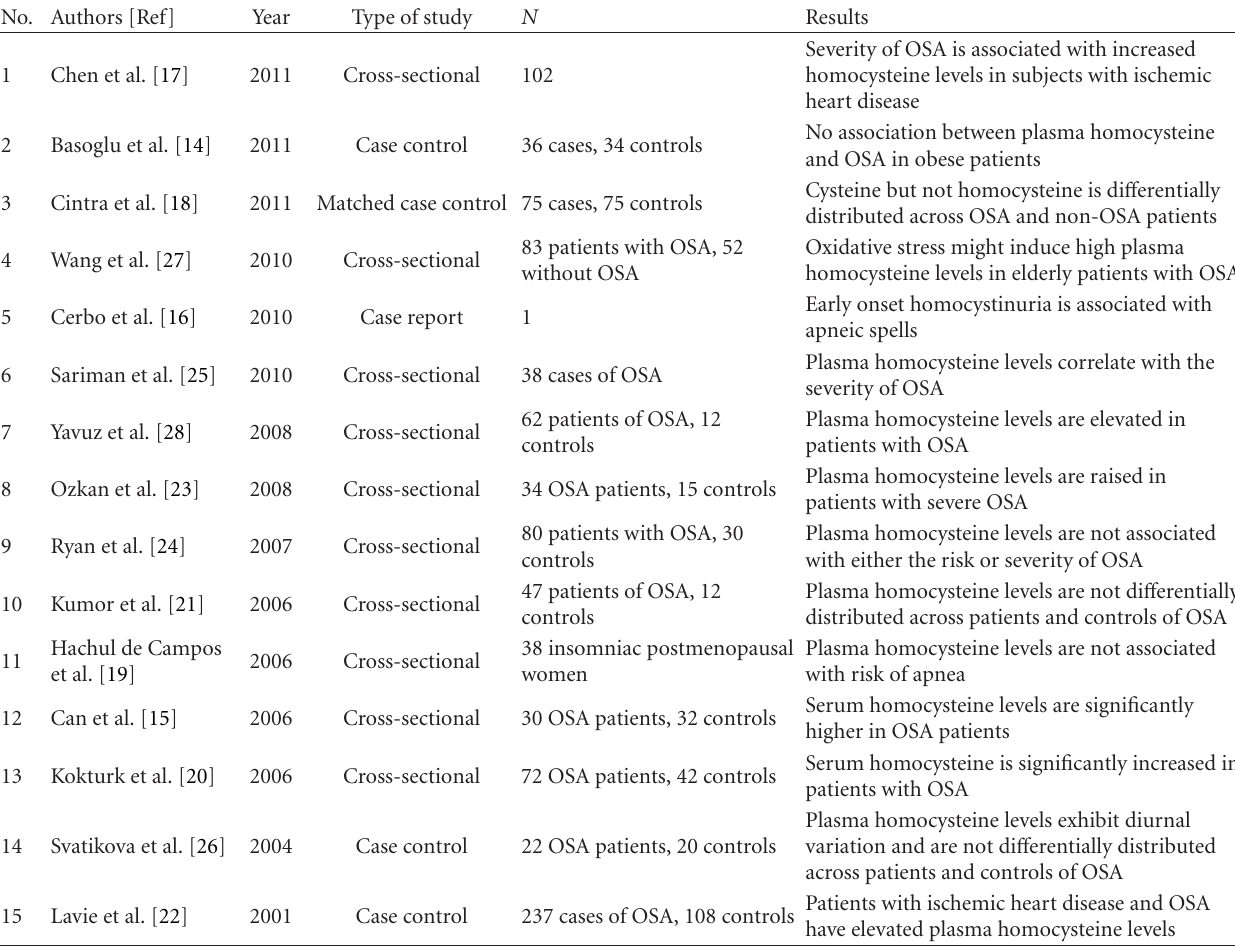
Table 1: Summary of evidence for and against the association of plasma homocysteine with sleep